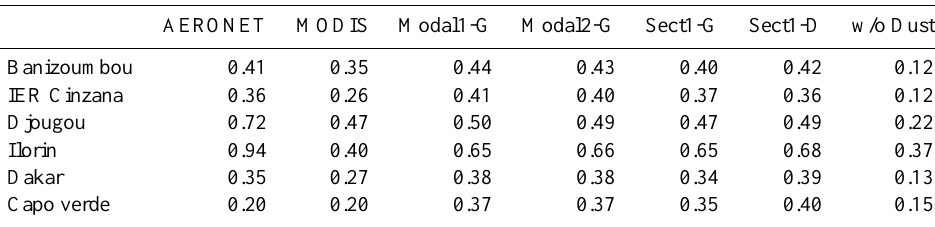
Table 2. AOD at 550nm from various measurements and WRF-Chem simulations. AERONET MODIS Modal1-G Modal2-G Sect1-G